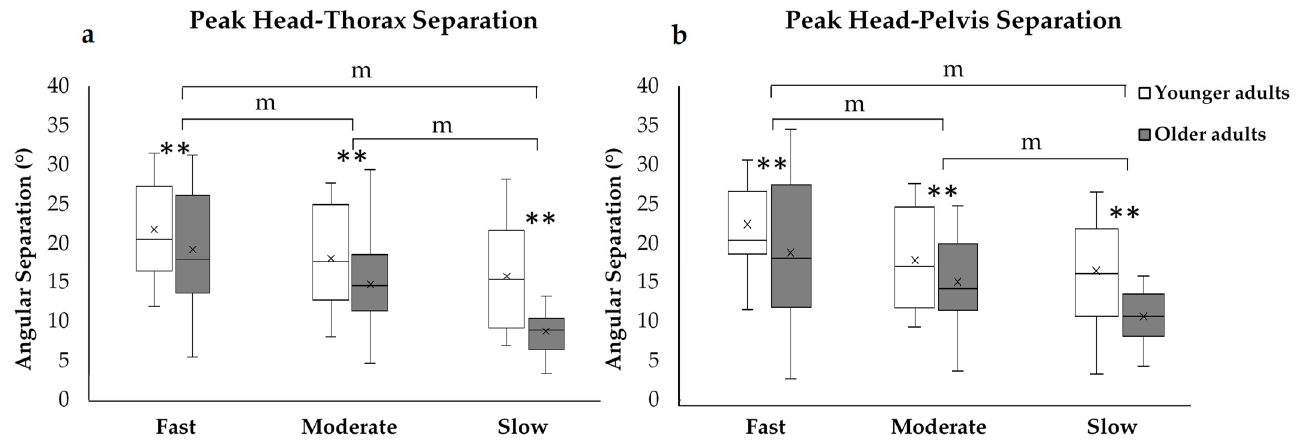
Figure 5. The effects of turning speed on mean ( a ) peak head–thorax angular separation and ( b ) peak head–pelvis angular separation under both conditions. The box and whisker plots illustrate the median peak head–thorax angular separation and peak head–pelvis angular separation. ** Indicate main effects of group and turn speed from MM ANOVA. m Indicates post-hoc pairwise with a Bonferroni adjustment for multiple comparisons from MM ANOVA.